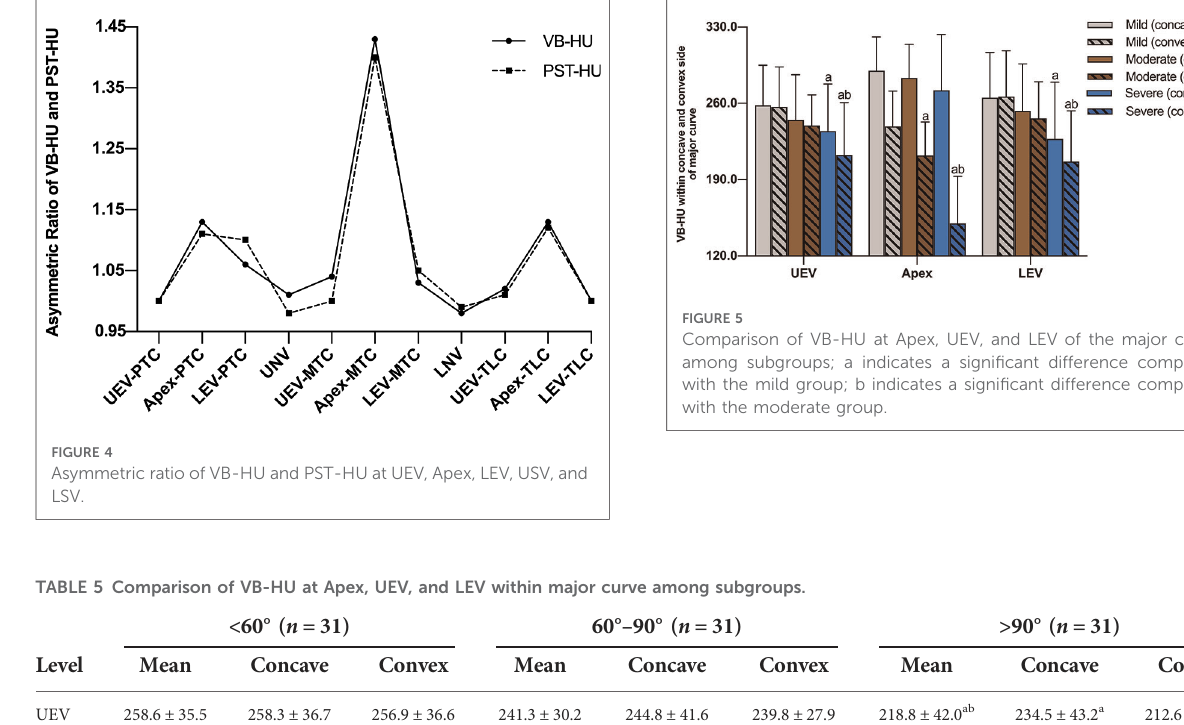
a indicates a signi fi cant difference compared with <60° group. b indicates a signi fi cant difference compared with 60° – 90° group. VB-HU, the Houns fi eld Unit values of vertebral body; UEV, upper end vertebra; Apex, apical vertebra; LEV, lower end vertebra.